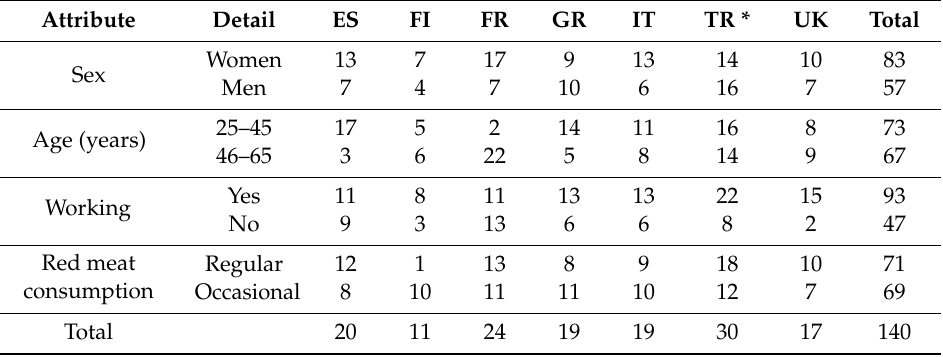
Table 1. Compositions of the focus groups by